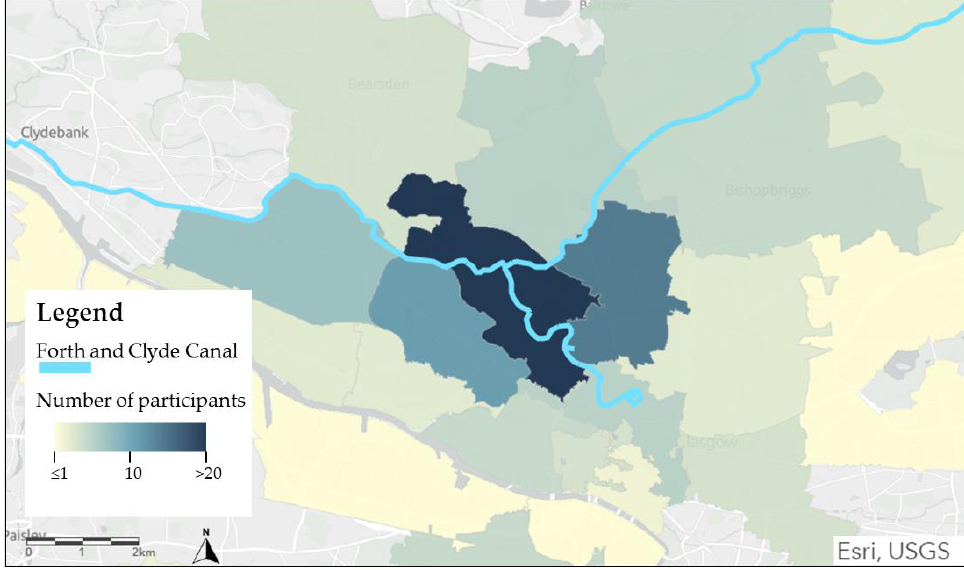
Figure 6. Map of North Glasgow showing the number of participants from each postcode. Map designed in Esri ® ArcGIS online, 2022.